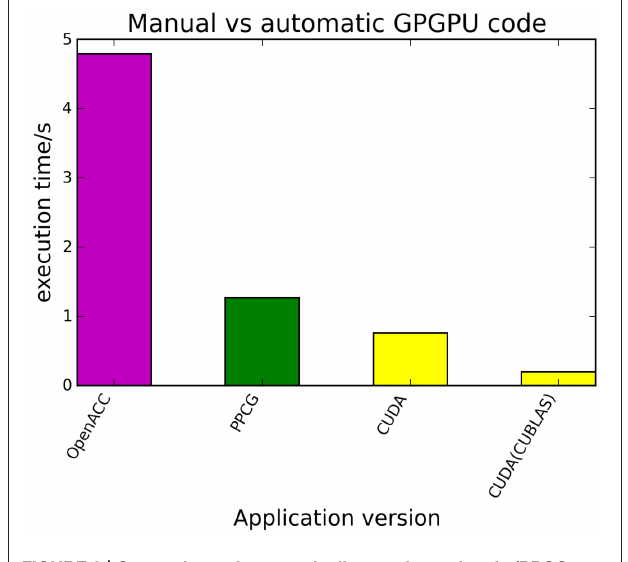
FIGURE 9 | Comparison of automatically transformed code (PPCG, OpenACC) and manually optimized CUDA Code for the matrix multiplication of two 4096 square matrices.